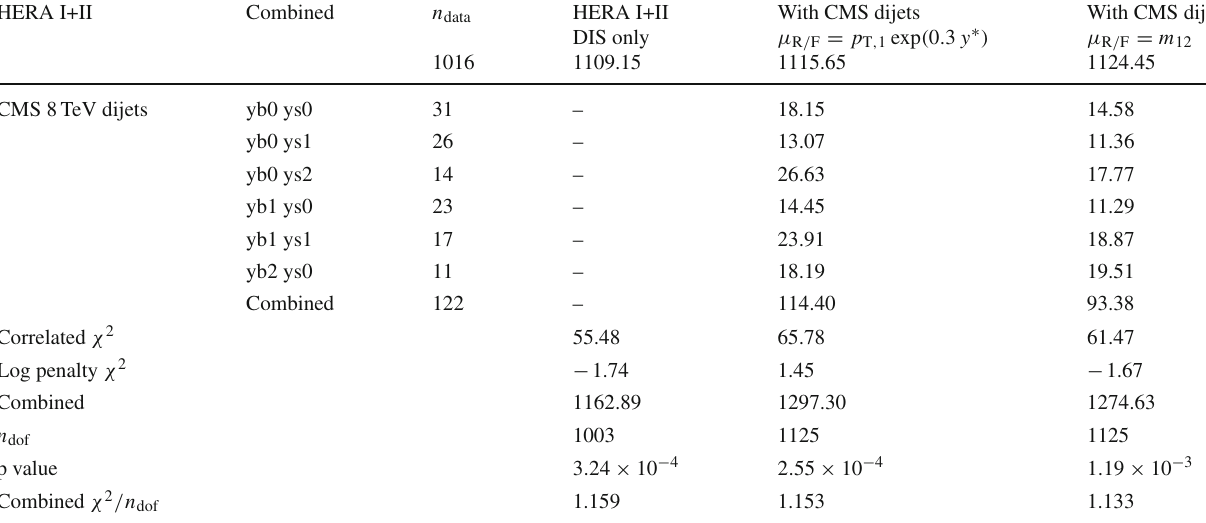
Table 5 Partial χ 2 values for the NNLO fits of Sect.